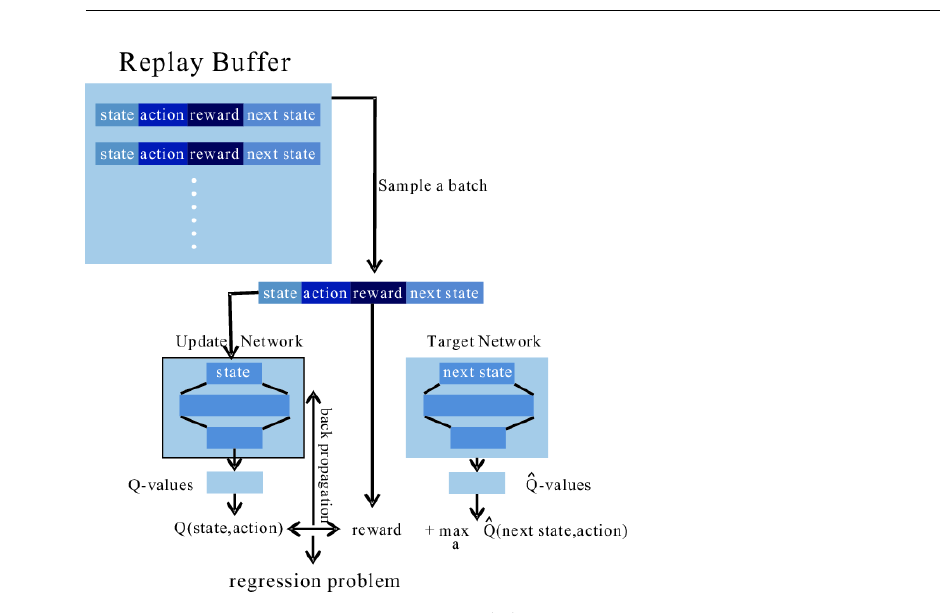
Figure 4. Deep Q-Learning Training